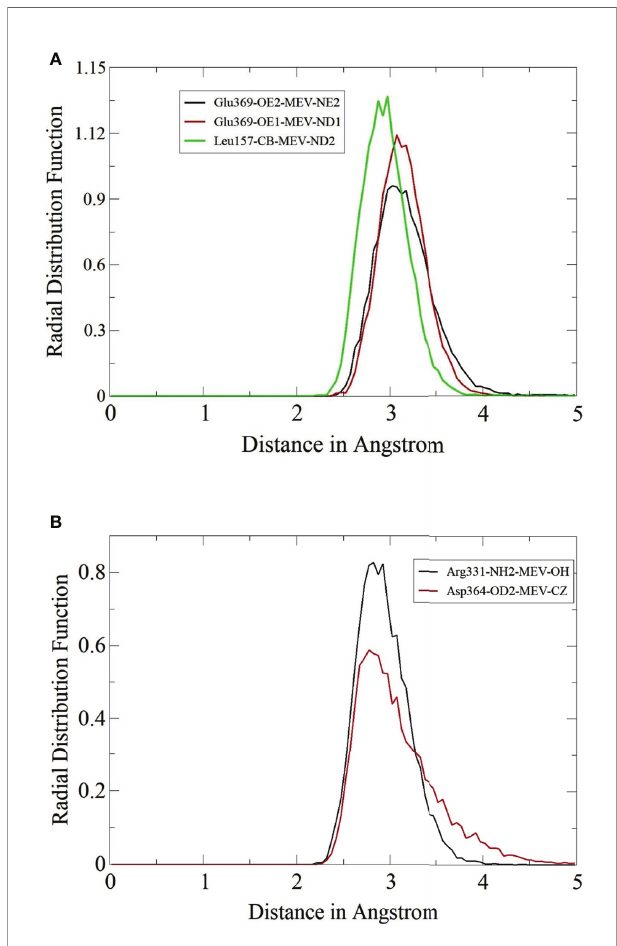
FIGURE 8 | Radial distribution plots for close interactions of MEV and TLRs. (A) Plots for MEV and TLR2 and (B) Plots for MEV and